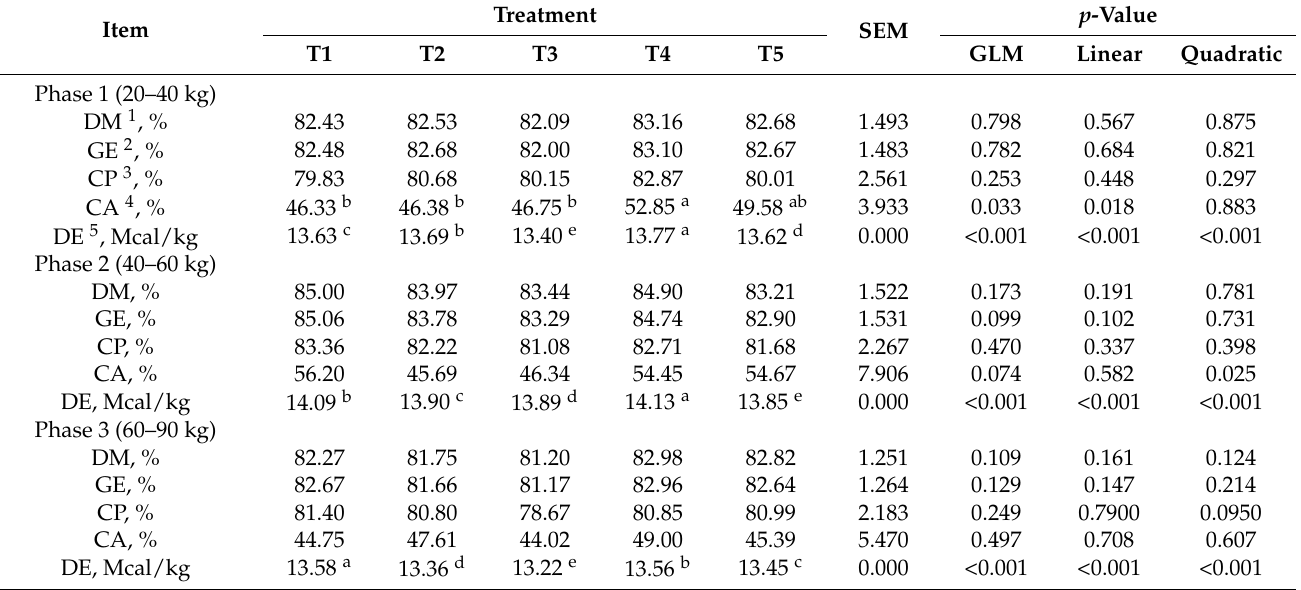
Table 4. Effect of dietary SID lysine levels on apparent nutrient digestibility of Baqing pigs at 20–90